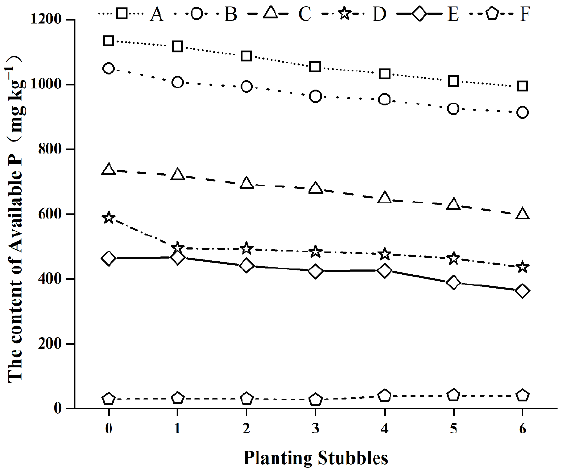
Figure 2. Changes in available P in the experimental soils over successive planting stubbles.